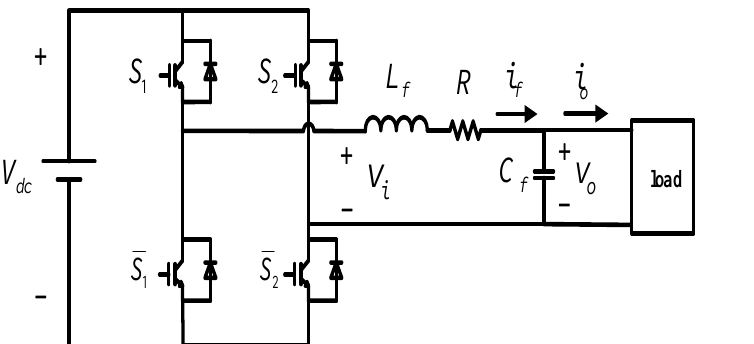
Figure 1. Single-phase inverter with output LC filter [35].